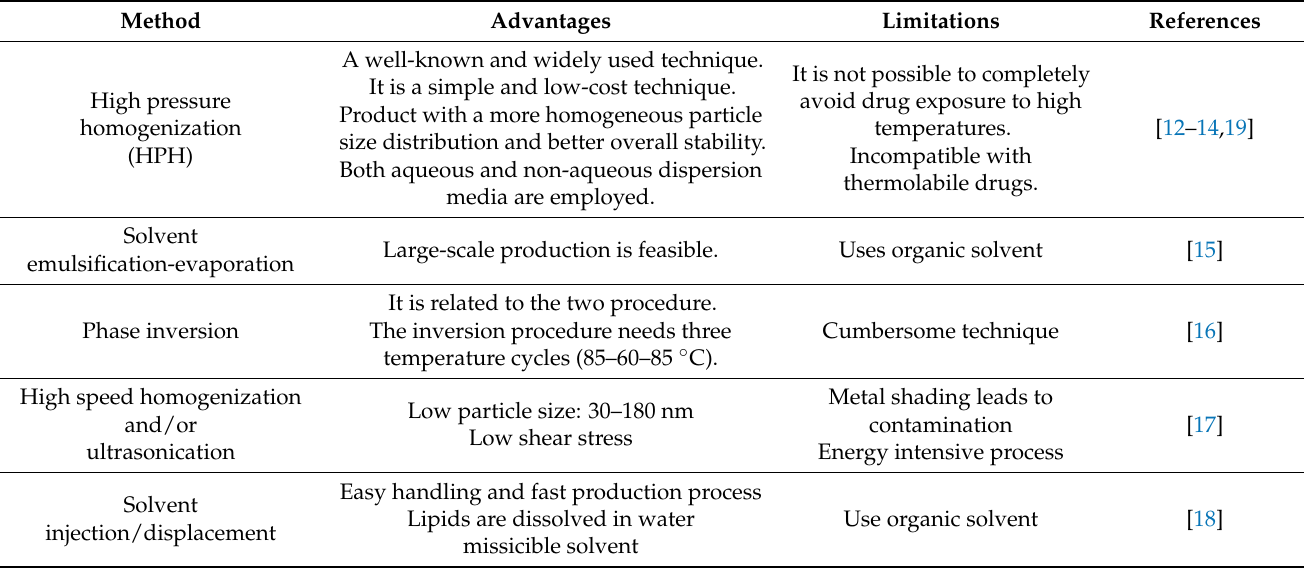
Figure 1. Composition of nanostructured lipid carriers (NLC) consisting of solid lipid, liquid lipid (oil), drug, surfactant and aqueous phase (created with biorender.com (accessed on 2 September 2021)). Table 1. Preparation method of NLC with its advantages and